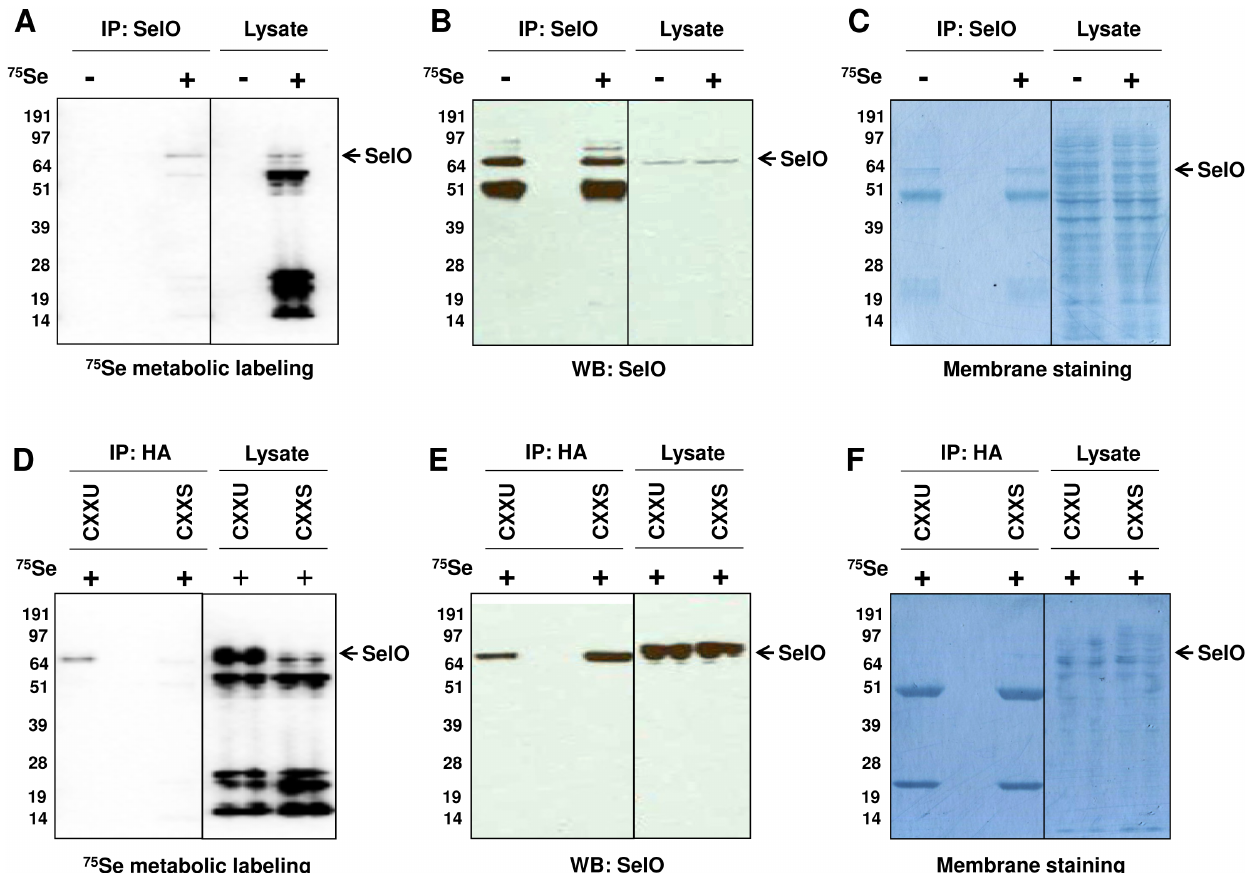
Figure 4. Incorporation of selenium into mammalian SelO. Endogenous SelO was metabolically labeled with 75 Se in HEK293T cells. Cell lysate was immunoprecipitated with anti-SelO antibody and visualized by (A) phosphorimaging and (B) Western blotting with anti-HA antibody. (C) Amido black staining shows equal loading. The 75 Se labeled cell lysate was also immunoprecipitated with anti-HA antibody. SelO in this sample was visualized by (D) phosphorimaging and (E) Western blotting with anti-SelO antibody. (F) Amido black solution was used to stain the membrane for loading control.